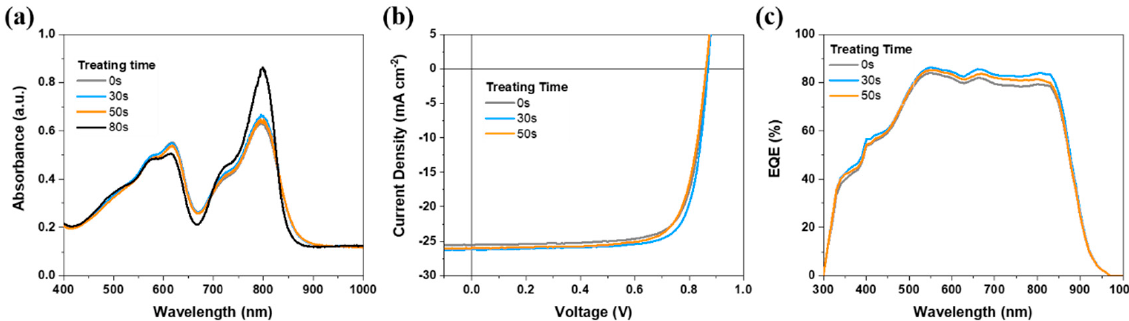
Figure 2. ( a ) UV–vis absorption of active layers. ( b ) J – V characteristics. ( c ) EQE spectra.